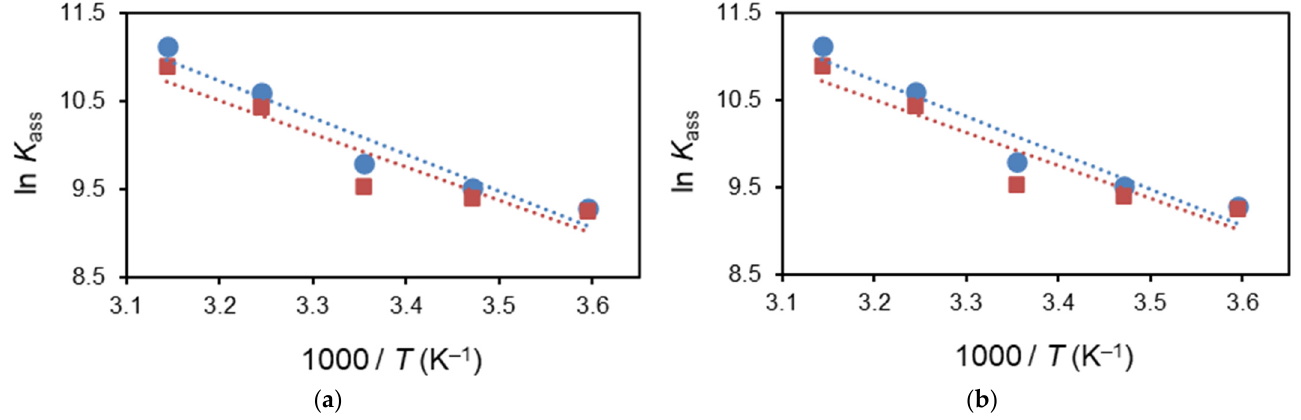
Figure 7. Linear regression of ln K ass vs. 1000/ T using UV–Vis absorption (circles) and fluorescence (squares) for urea 4a in MeCN (2.0 × 10 –5 M) upon addition up to 10 equiv of ( a ) TBA F and ( b ) TBA AcO. Table 4. Thermodynamic quantities for the complexation of anions with 4a in MeCN at 25 °C determined by UV–Vis and fluorescence.